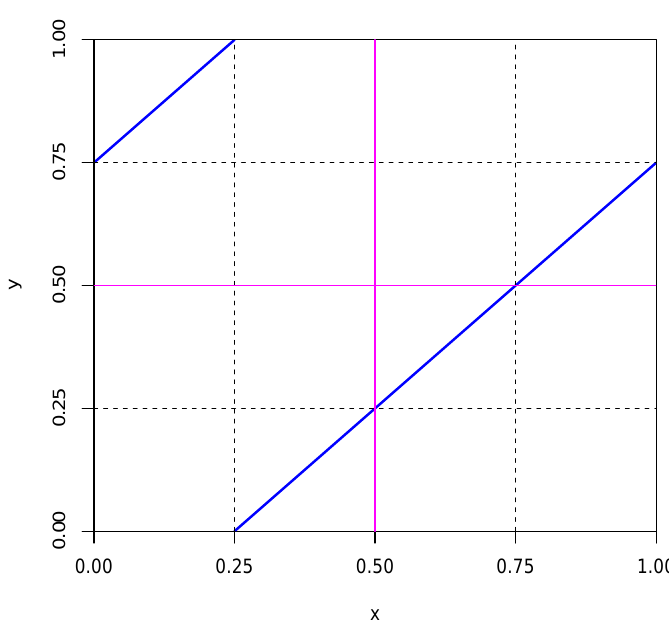
Figure 1: Completely dependent copula A h with maximal D 1 -asymmetry as considered in Example